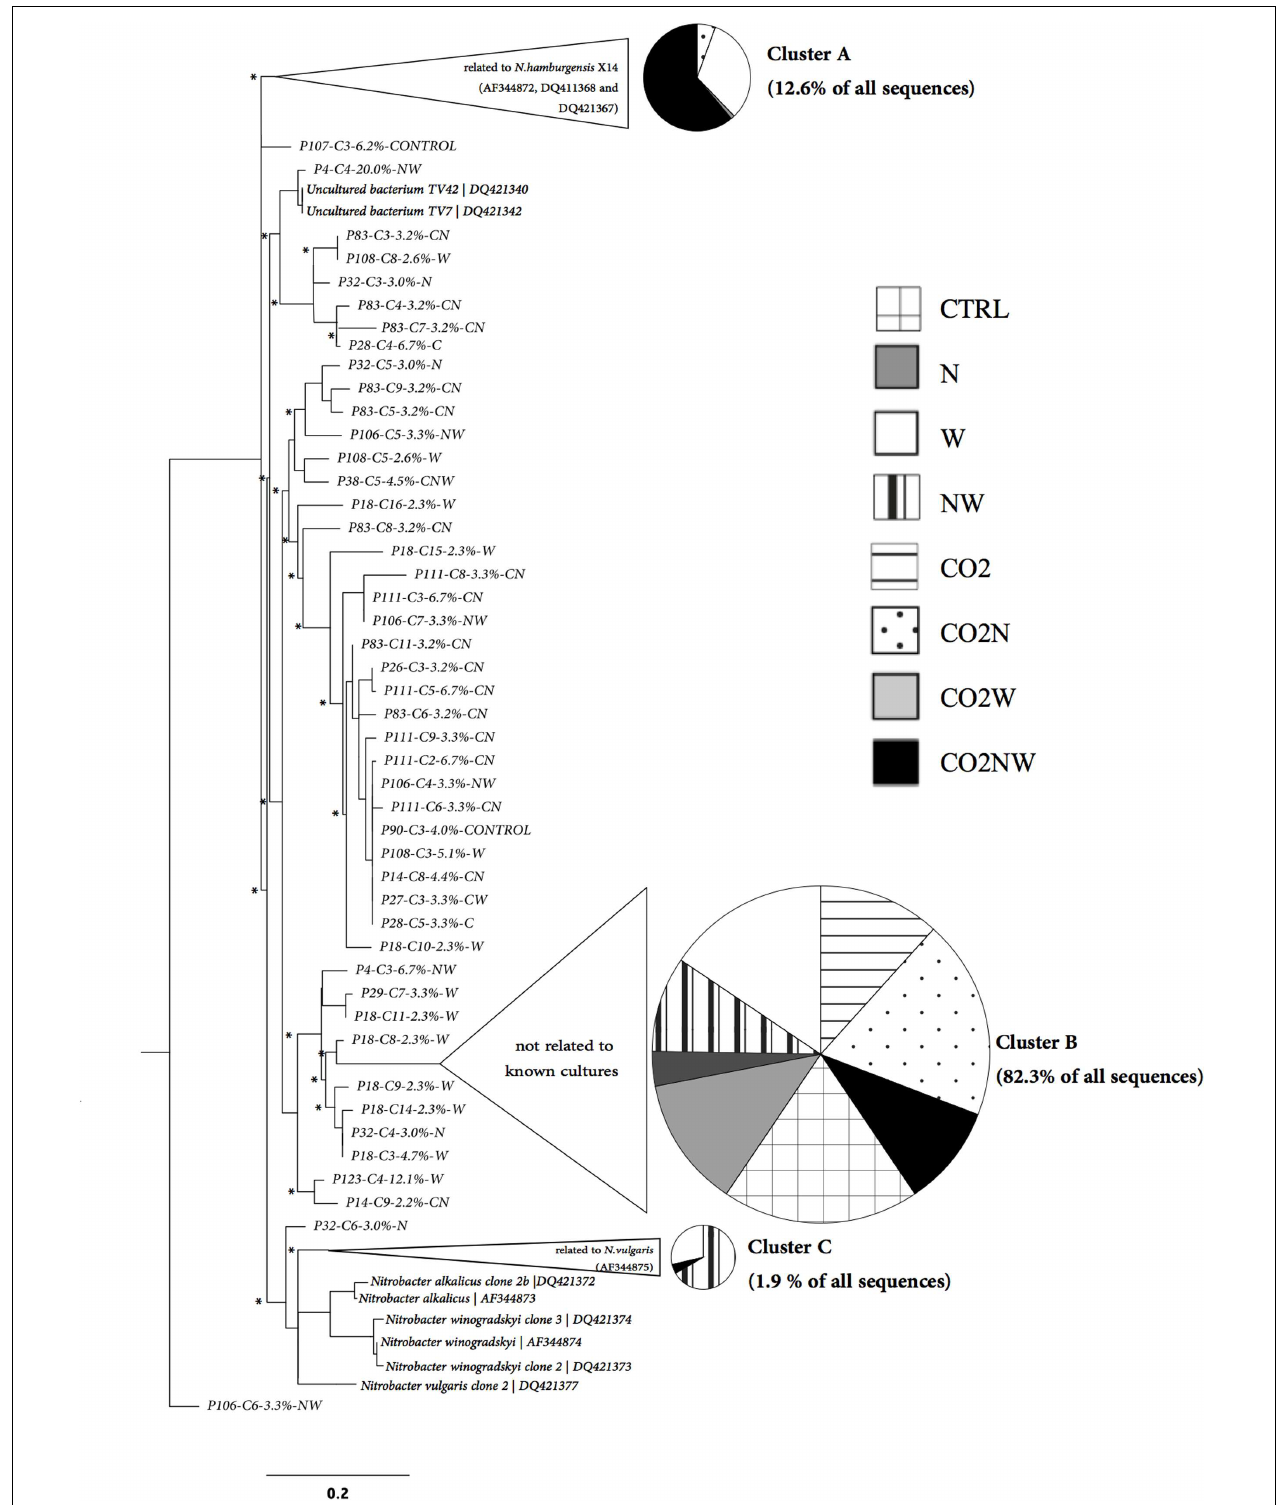
FIGURE 2 | Phylogenetic tree of Nitrobacter -like nxrA sequences retrieved from soils experiencing different global change treatments in relation to nxrA sequences of cultivated strains. Disks represent the distribution of nxrA sequences among treatments for the three main clusters identified (Unifrac Significance for each: p < 0.001). These three clusters correspond to 96.8% of all the nxrA sequences retrieved across treatments and to more than 86% of nxrA sequences retrieved for each treatment.